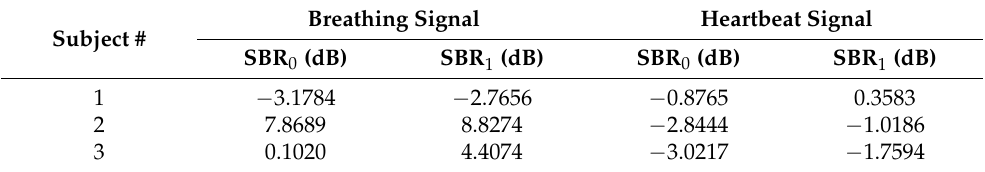
Table 5. SNR comparison before and after Iterative VMD Wavelet-Interval-Thresholding.